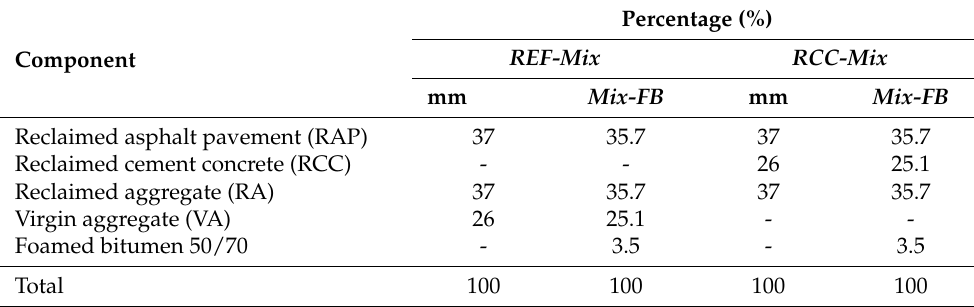
Figure 11. REF-Mix and RCC-Mix mixture specimens prepared for unconfined compressive strength tests [48]. Table 12. Composition of mineral mixtures (mm) and mineral mixtures with foamed bitumen ( Mix-FB ) [48].